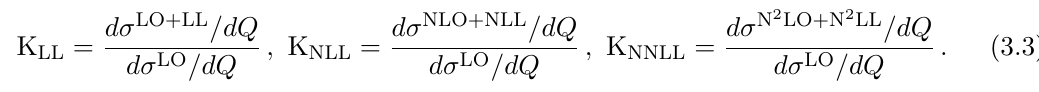
uncertainty r = Q = M we 1 f = 1500 for the variation in the 1